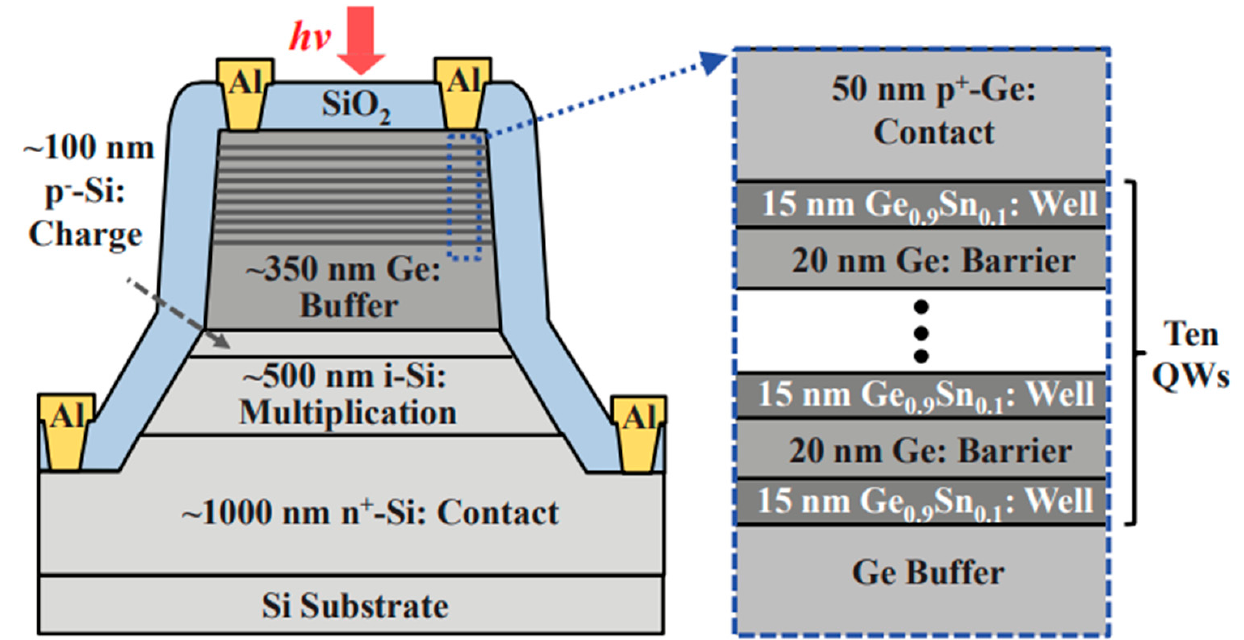
Figure 17. Cross-sectional schematic of GeSn/Ge MQWs APD with SACM structure. Reproduced with permission from [75], IEEE, 2015.